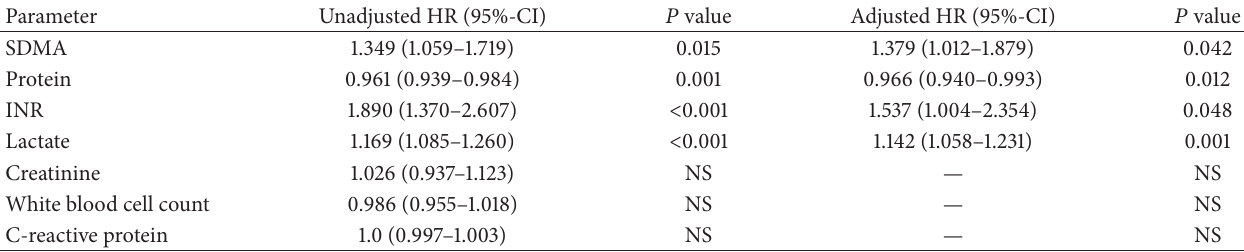
Table 4: Uni- and multivariate Cox regression analyses for SDMA levels at admission to predict ICU mortality.